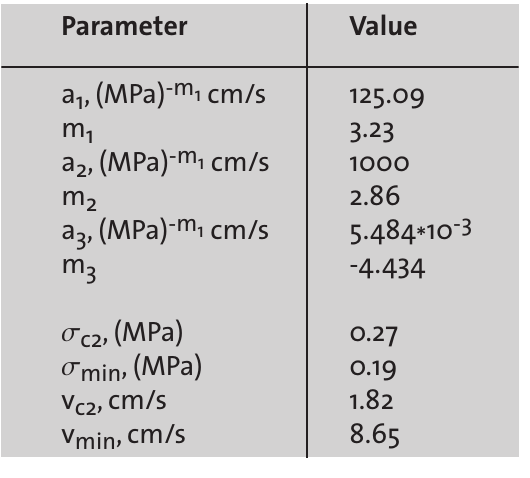
Table 1: Values of the slip model parameters.